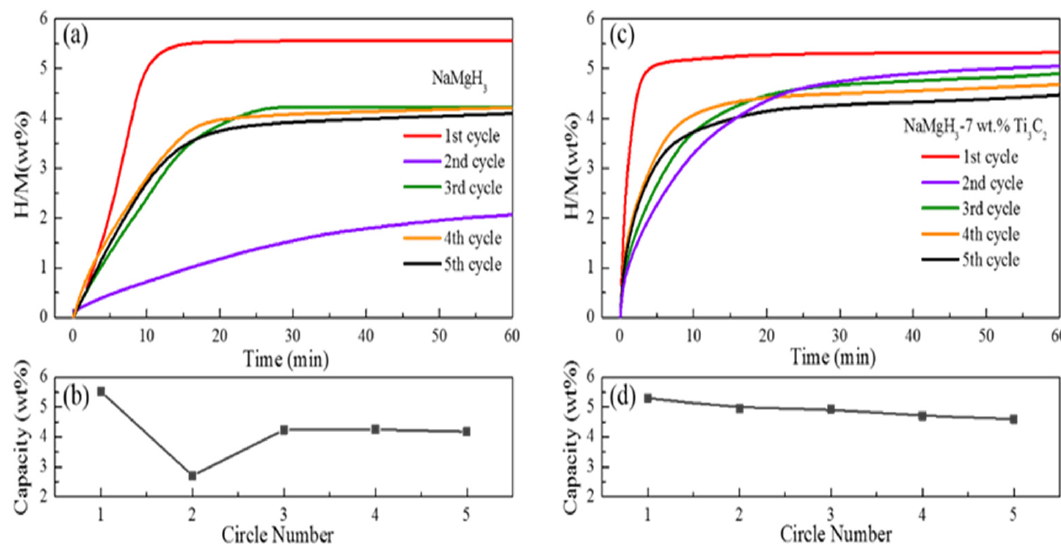
Figure 7. Isothermal dehydrogenation cycle curves of ( a ) NaMgH 3 and ( c ) NaMgH 3 -7 wt.% Ti 3 C 2 at 400 °C; cycle capacity curves of ( b ) NaMgH 3 and ( d ) NaMgH 3 -7 wt.% Ti 3 C 2 .